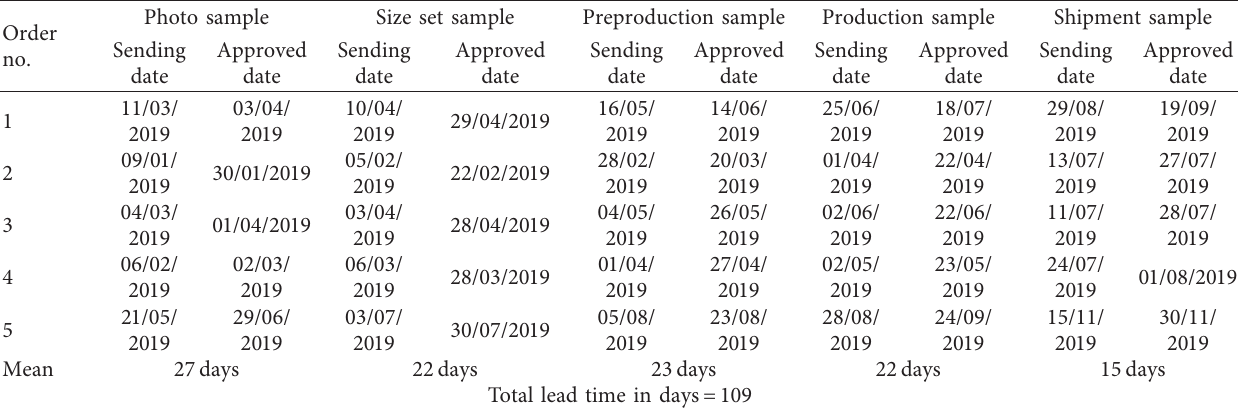
Table 2: Company B, date-wise sample approval data taken from five different orders.